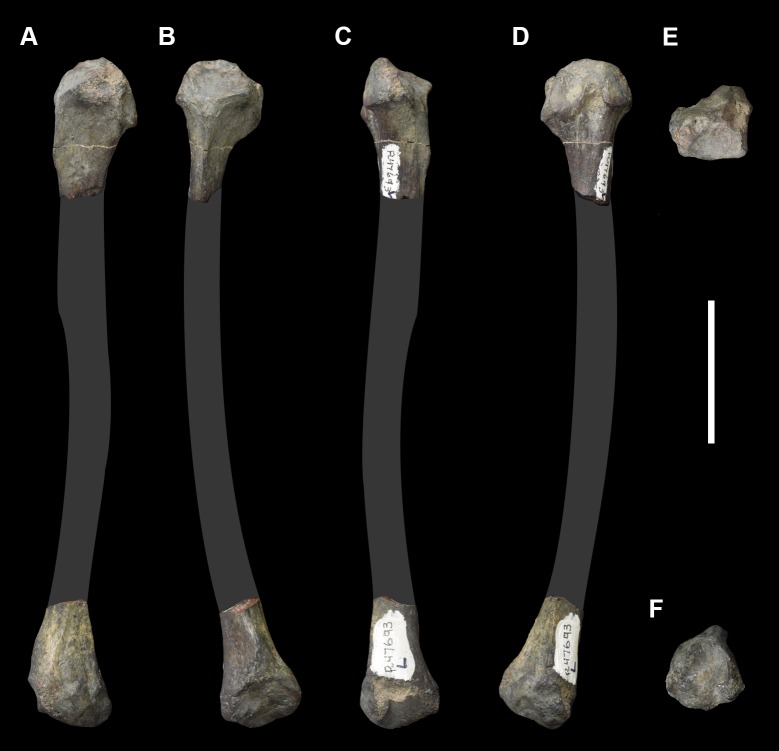
Left fibula of Periptychus carinidens (NMMNH P-47693).(A) anterior view; (B) medial view; (C) posterior view; (D) lateral view; (E) proximal view, (F) distal view. Scale bar: 30mm.